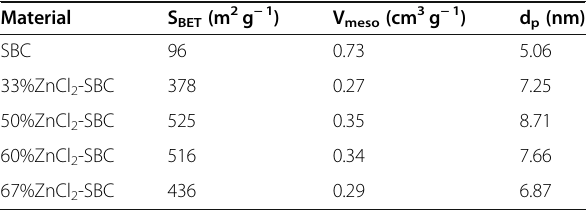
Table 1 The surface area and pore volume of